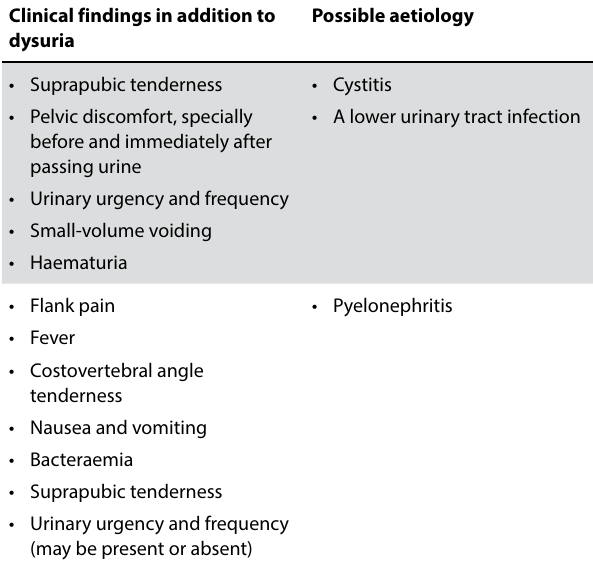
Table II: Clinical findings in women with dysuria